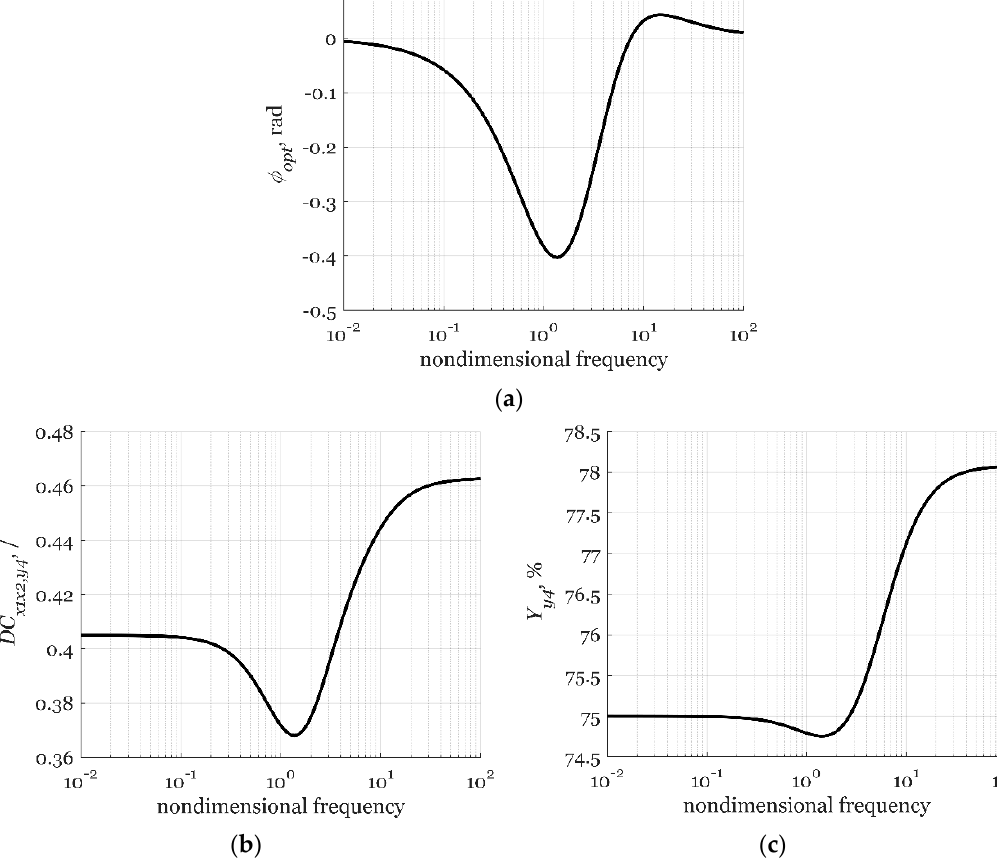
Figure 11. Simulated results for simultaneous modulation of the inlet reactant concentration and flow rate with forcing amplitudes A 1 = A 2 = 0.9: ( a ) optimal phase angle, ϕ opt , maximizing the outlet product molar flow rate; ( b ) the DC component for the outlet molar flow rate of the product MF P ( y 4 ), and ( c ) the corresponding product yield, Y y 4